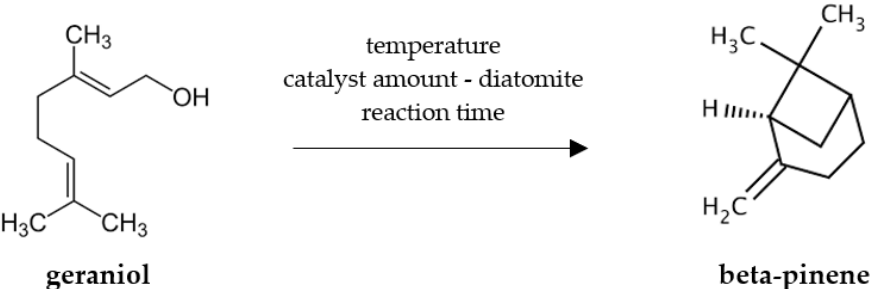
Figure 1. Reaction scheme for the transformation of geraniol to beta-pinene.